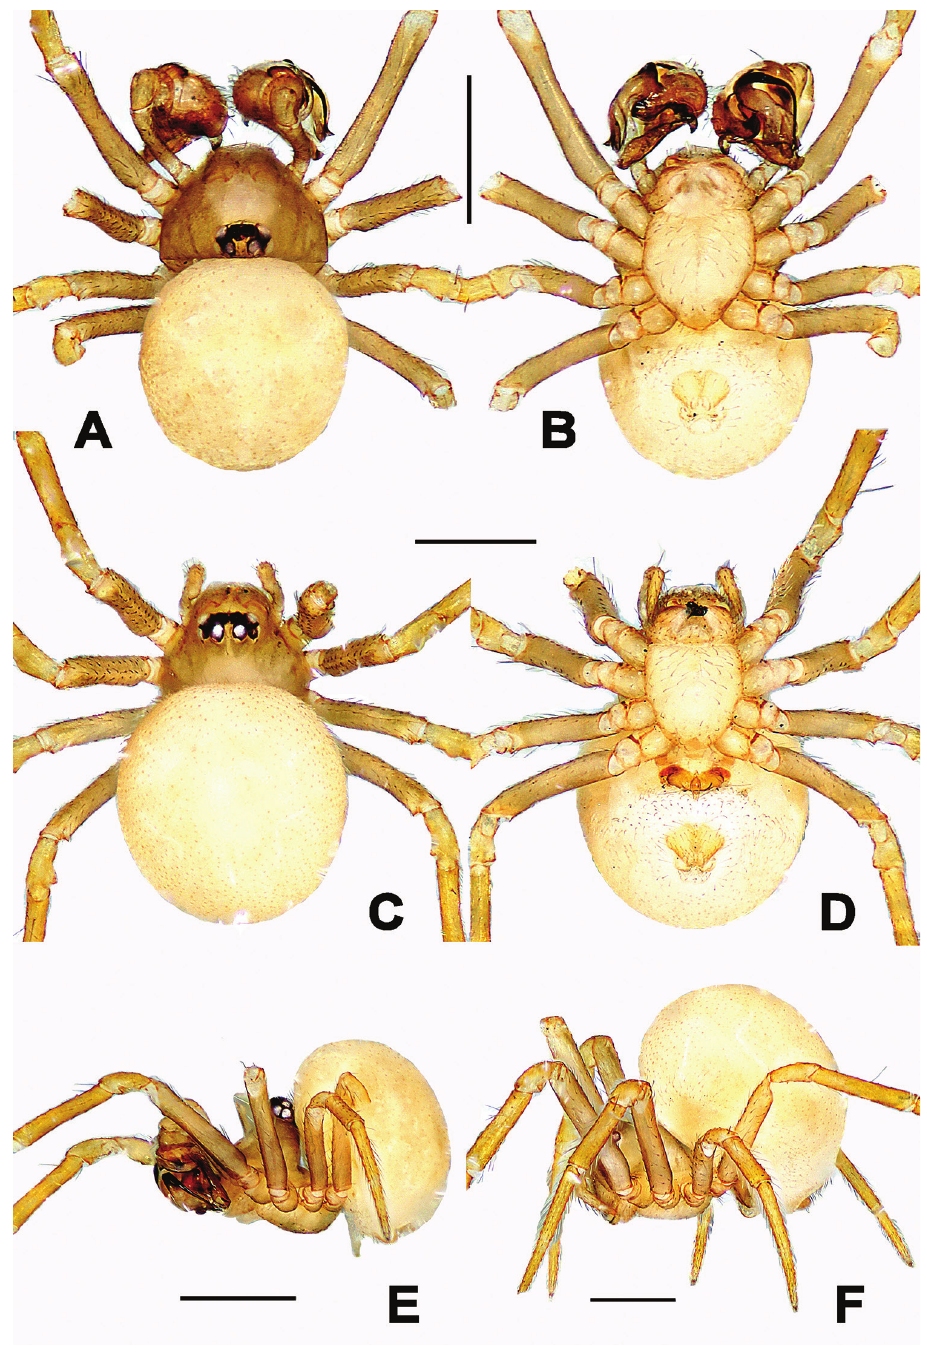
Figure 9. Trogloneta yunnanense (Song & Zhu, 1994) comb. n., male habitus ( A, B, E ) and female habi- tus ( C, D, F ). A, C dorsal B, D ventral E, F lateral. Scale bars: 0.50